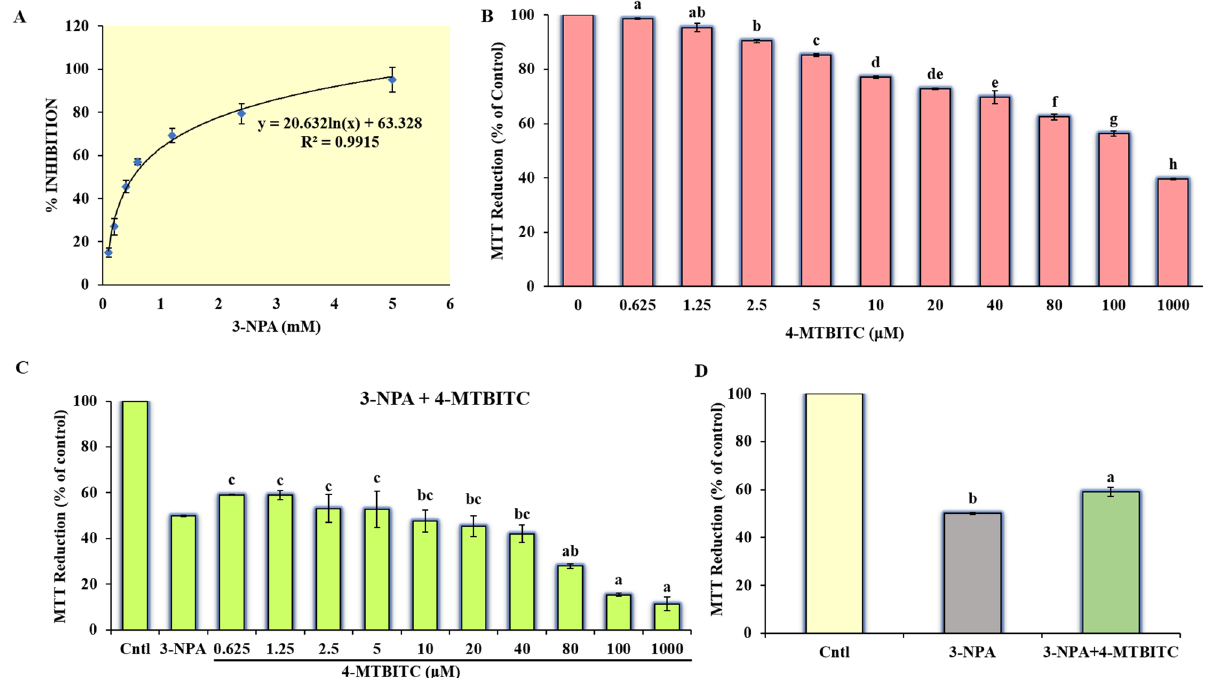
Figure 3. ( A ) Dose-dependent cytotoxicity profile of 3-NPA (0.1–5 mM) in SH-SY5Y cells; ( B ) Dose- dependent cellular viability of 4-MTBITC alone; ( C ) Dose-dependent study of cellular viability of pretreatment of 4-MTBITC (0.625–1000 μM) against 0.5 mM 3-NPA exposed cells for 24 h; ( D ) Representation of cellular viability of optimal cytotoxic dose of 3-NPA (0.5 mM) and optimal cytoprotective dose of 4-MTBITC (1.25 µM) used in combination with 3-NPA. MTT assay results detected the cellular viability as the percentage of reduction in MTT with comparison to control. The measurements are represented as the mean ± SE at the level of significance p ≤ 0.05. Small letters as data labels indicate statistical difference comparatively to control by one- way ANOVA, followed by the Tukey post hoc test.